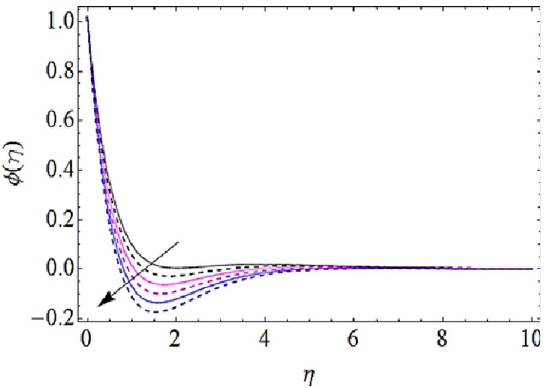
Fig 14. Concentration characteristics for various values of thermophoresis parameter.